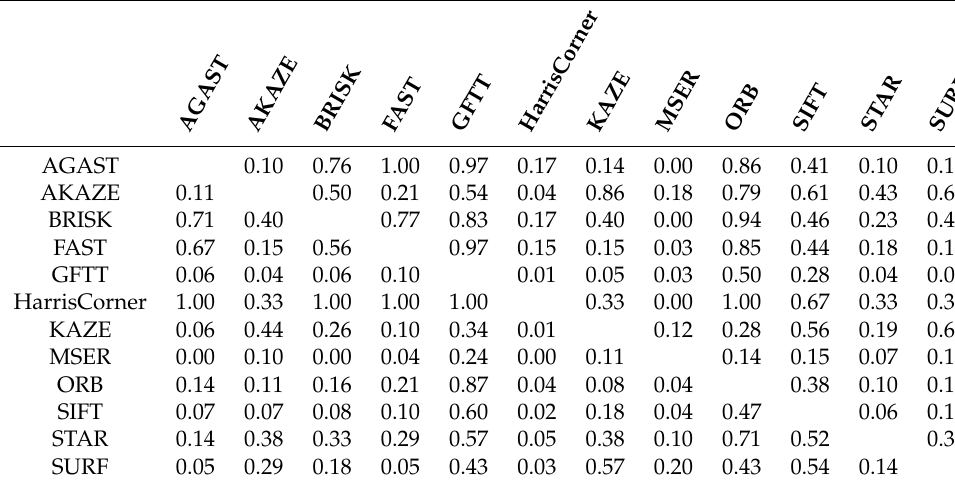
Table 3. The percentage of keypoint repetitions (with an up to 3-pixel distance between points considered as overlapping) detected using the considered